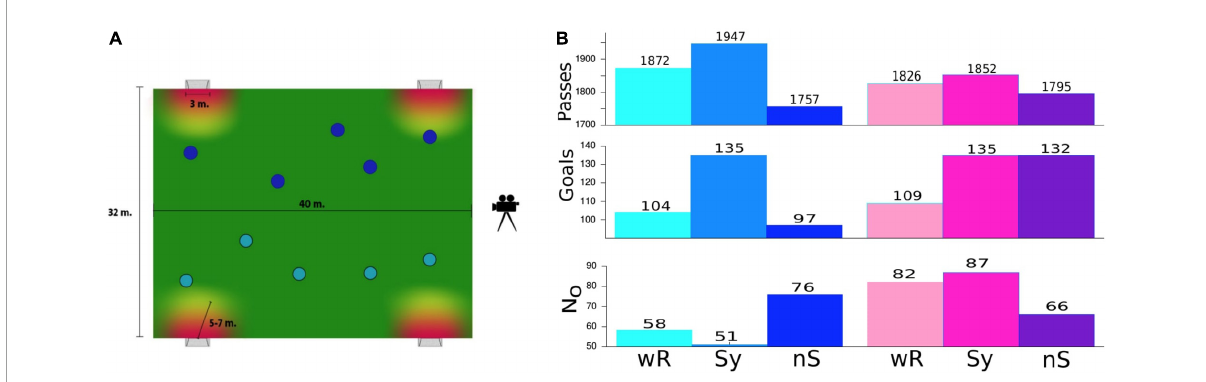
FIGURE1 (A) . Sketch of the soccer field. Scoring was only allowed within a critical radius around the goal. This is a typical exercise routine, which is commonly implemented in training sessions to improve interpersonal coordination expressed by fast and precise pass sequences or, in the terminology of this study, to improve the connectivity of a team. (B) . Total number of passes and goals for male (blue colors, left) and female teams (pink colors, right) were obtained under the three experimental conditions. N0 denotes the number of ball possessions of a team without any pass. wR = without rhythmic acoustic stimuli, Sy = rhythmic acoustic stimuli displayed collectively in a synchronous fashion at 140 bpm, nS = rhythmic acoustic stimuli displayed collectively but each player with another tempo.